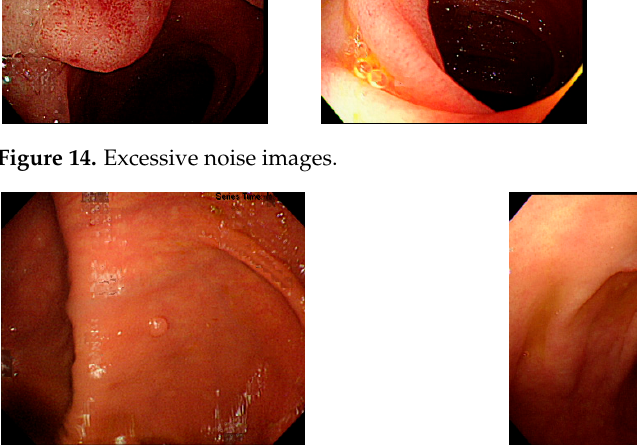
Figure 15. Small pixel size polyp images.